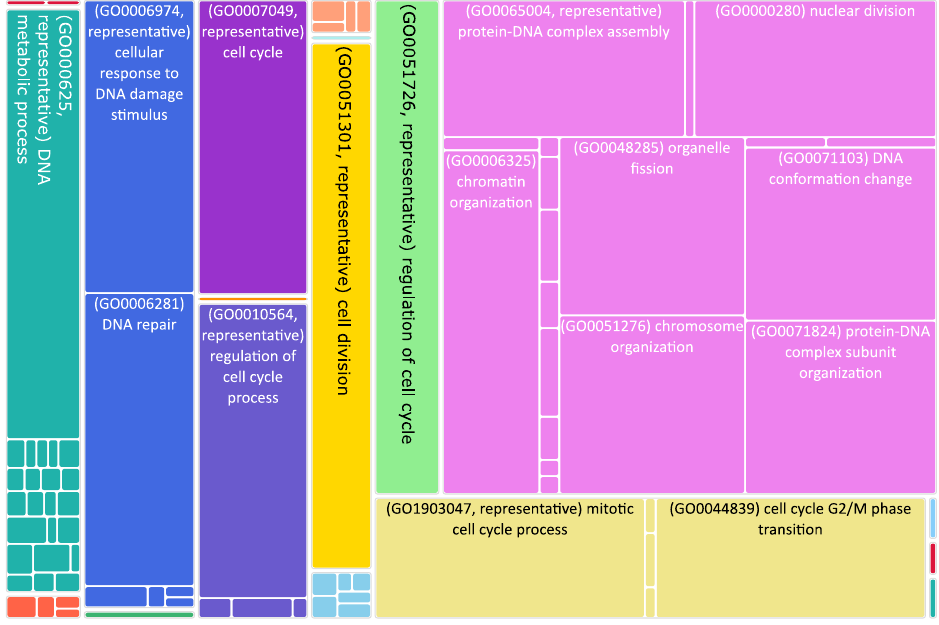
Figure 3. Tree map of upregulated genes in the stage 4 + 4S. Each rectangle is a single cluster representative. The representatives are joined into “superclusters” of loosely related terms, visualized with different colors. Sizes of the rectangles are adjusted to reflect the p -value of the GO term (“biological process”). Most representative terms are indicated. Upregulated genes in the stage 4 + 4S are prevalently associated with cell cycle regulation.